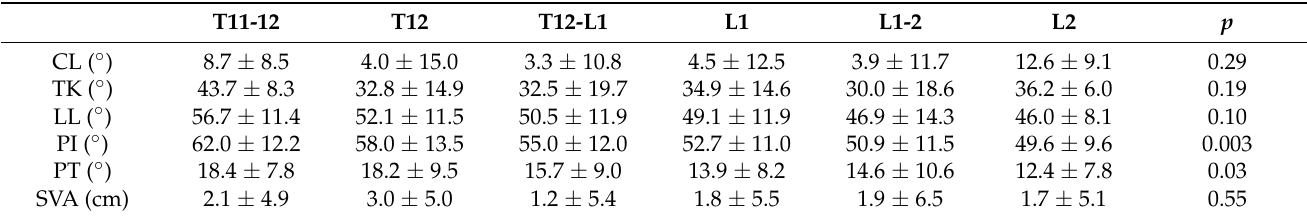
Table 2. The association between the conus medullaris level and radiographical parameters.